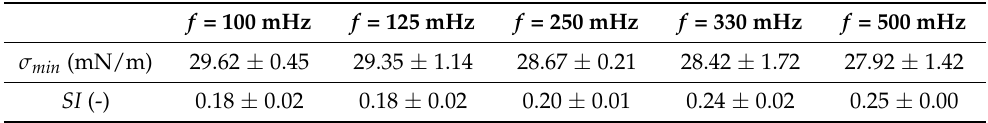
Figure 2. Stability index ( SI ) of the air–water or air–saline interface in the presence of MPS and VMs: ( a ) SH, ( b ) XG, and ( c ) AG. Table 1. The minimum values of surface tension, σ min , and SI for MPS at the air–water interface at different frequencies of surface